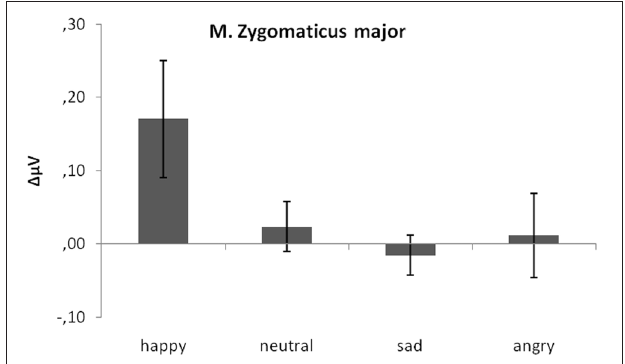
FIGURE 3 | Mean EMG change from baseline in µ V for M. zygomaticus major in response to happy, neutral and sad faces. Error bars indicate standard errors of the